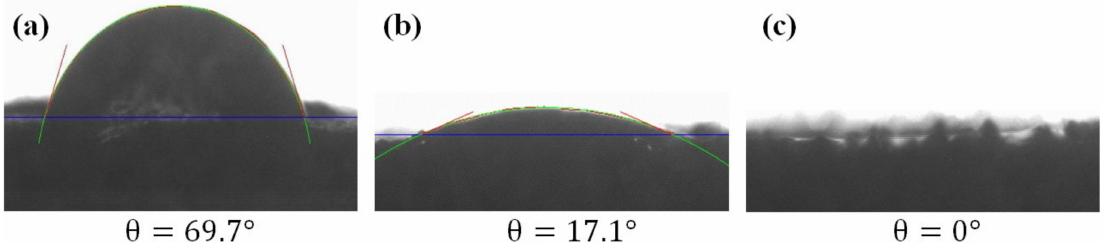
Figure 7. ( a ) Contact angle of the rock saturated with non-aqueous drilling fluids (NAF), ( b ) contact angle after treatment with system 1, and ( c ) contact angle after treatment with systems 2 and